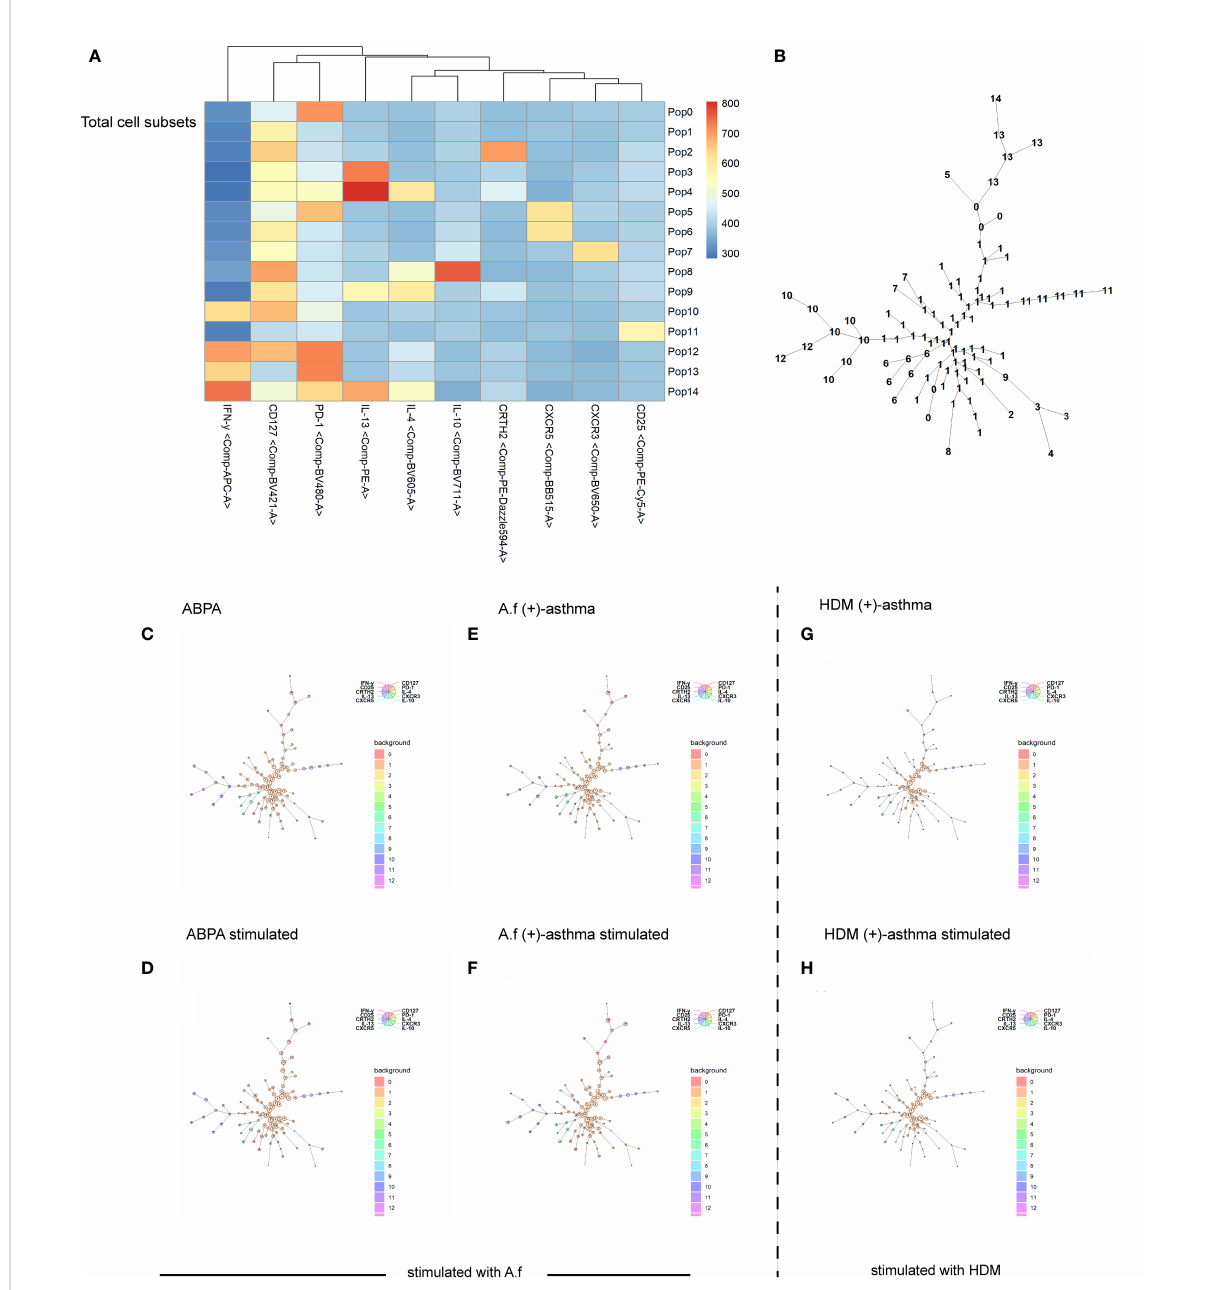
FIGURE 9 FlowSOM algorithm. Spanning tree visualization of a self-organizing map using compensated fl ow cytometric data. Data were taken from the lineage (CD3+, CD4+) gate. (A) heatmap of the FlowSOM clustering; (B) minimal spanning tree for 15 metaclusters; (C – H) FlowSOM nodes represent clusters of cells. Metaclusters of the nodes, determined by the map, are represented by the background color of the nodes. A.f (+) asthma, Aspergillus fumigatus -sensitized asthma; HDM (+) asthma, house dust mite-sensitized